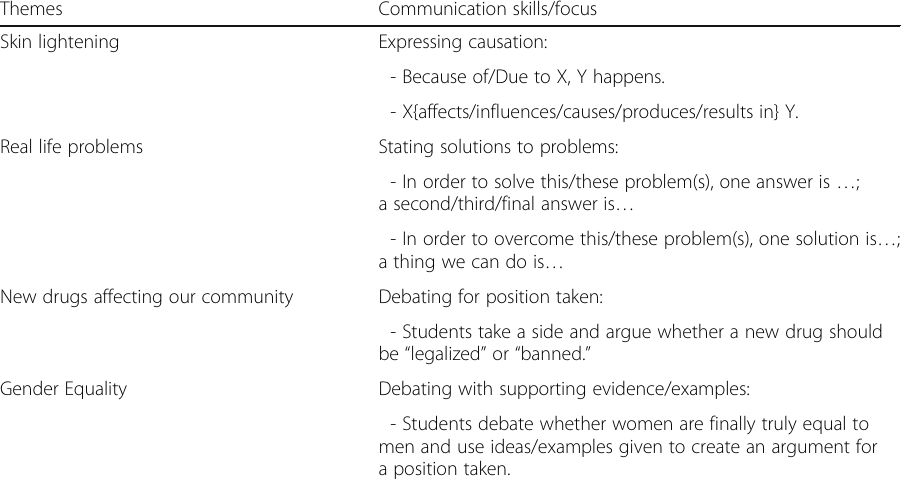
Table 1 Weekly themes and communication